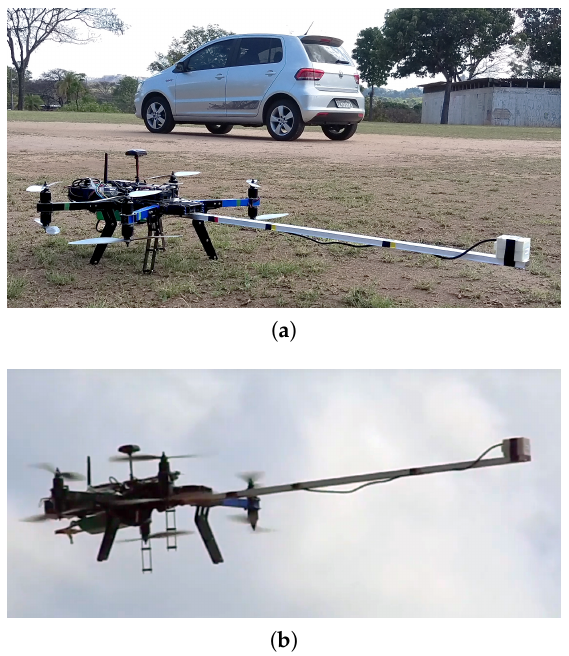
Figure 14. Field experiment scene. ( a ) The sensor components are being carried by the octarotor, and its core is supported by a pole of 1.1 m, in order to avoid as much as possible the magnetic interferences caused by the drone itself. In the background, the car used as the magnetic anomaly originator; ( b ) UAV flying a